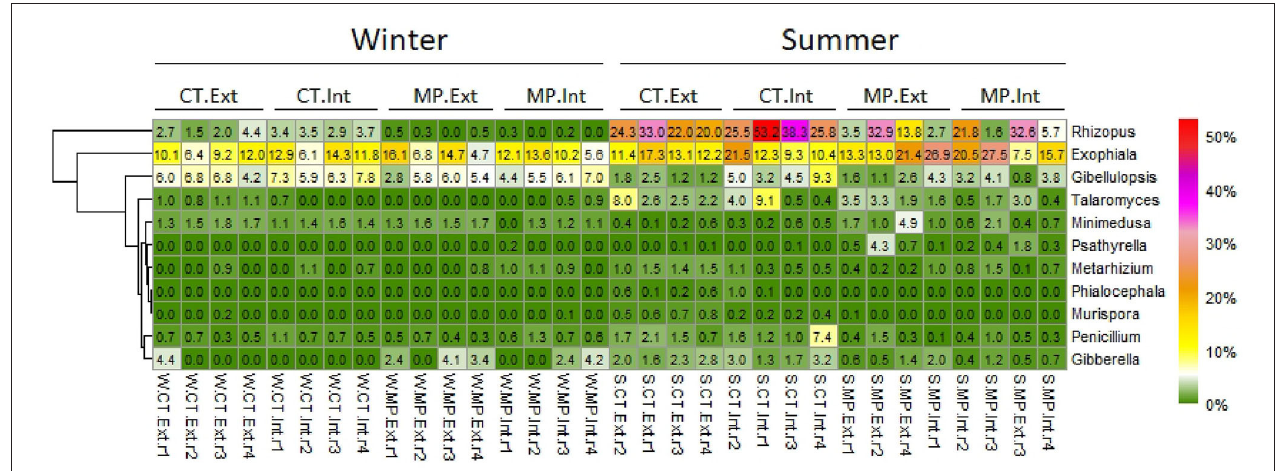
FIGURE 4 | Heatmap displaying the relative abundance distribution of fungal genera (responder) significantly affected (FDR < 0.05) by different long-term management practices (CT, Cultivator Tillage vs. MP, Moldboard Plow; Int, intensive vs. Ext, extensive) in soils sampled in LTE Bernburg in winter (W) or summer (S). Most abundant responders with average ( n = 4) relative abundance > 0.5% are shown. Pairwise comparisons between treatments with assignment into functional guilds are presented in Supplementary Tables 6, 7 .